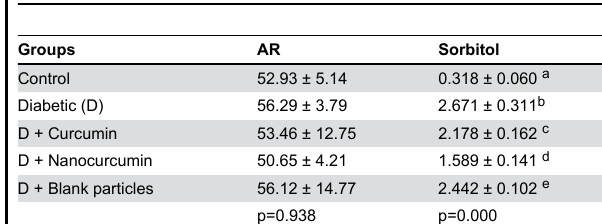
Table 2. The effect of curcumin and nanocurcumin on aldose reductase (AR) activity and sorbitol levels in rat lens.